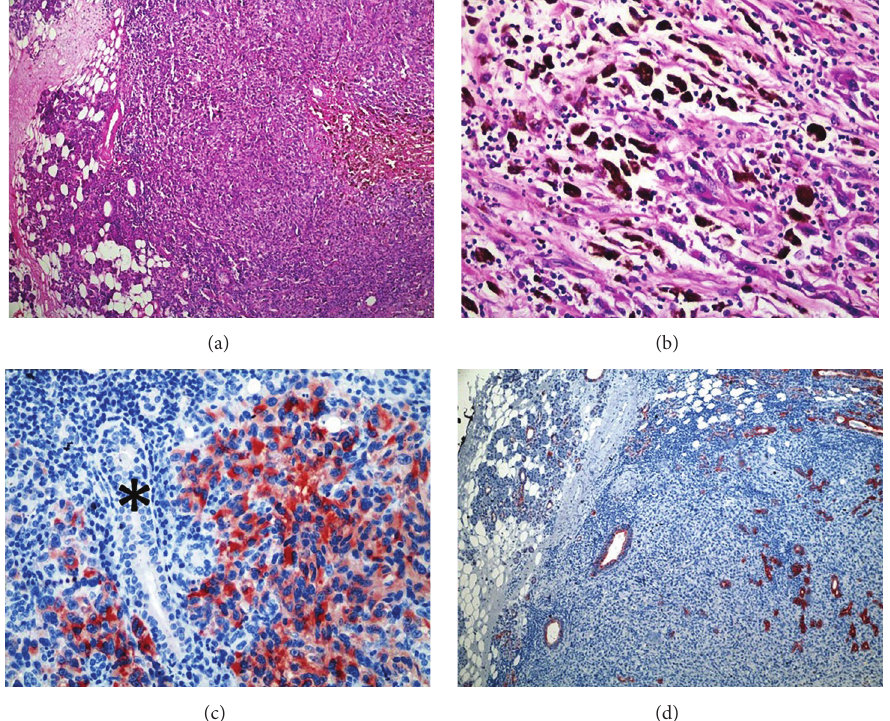
Figure 2: (a) Infiltrated parotid tumor. Normal parotid tissue in the left (residue) (100x HE). (b) The melanin-rich tumor (400x HE). (c) The analysis identified positive staining for HMB-45 (400x). Asterisk: salivary duct, negative staining for HMB-45. (d) Negative staining for PanCK of the tumor and positive staining for PanCK in the residue parotid tissue (PanCK,